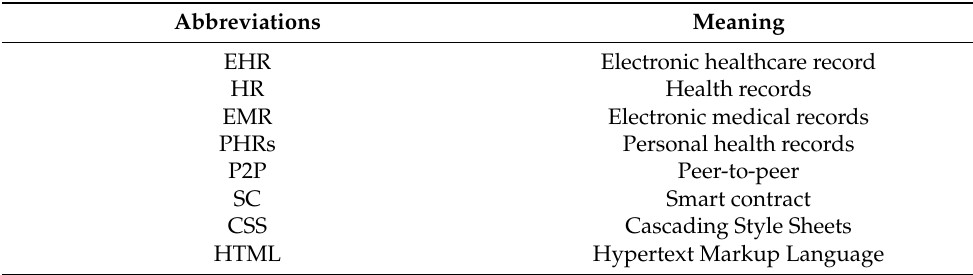
Table 1. List of abbreviations and acronyms used in the article.